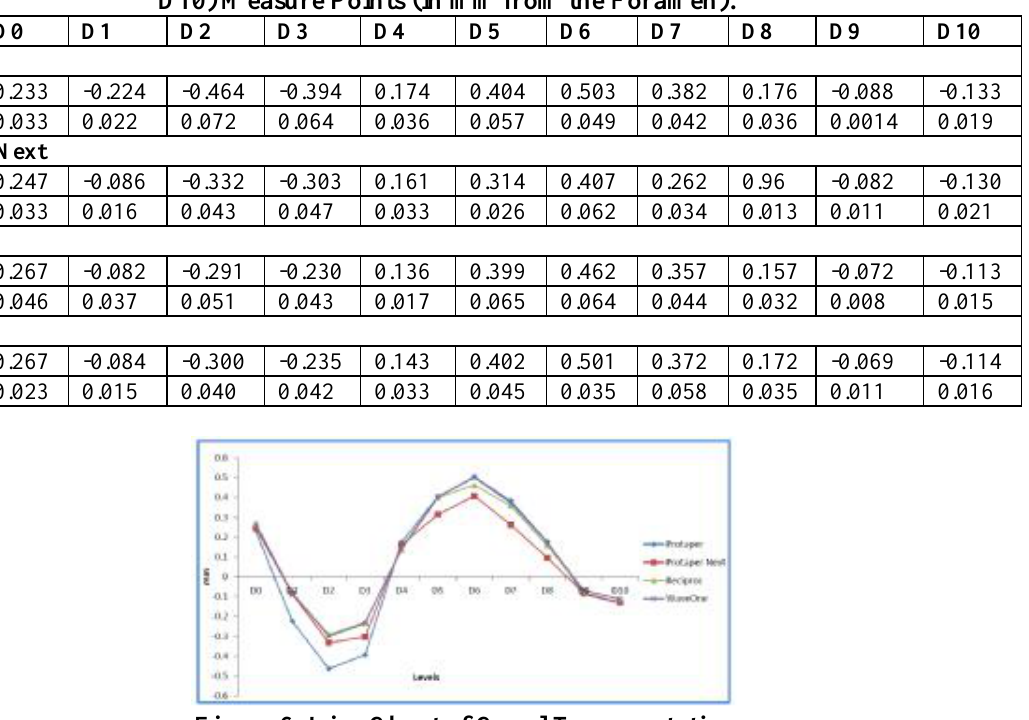
Figure 6: Line Chart of Canal